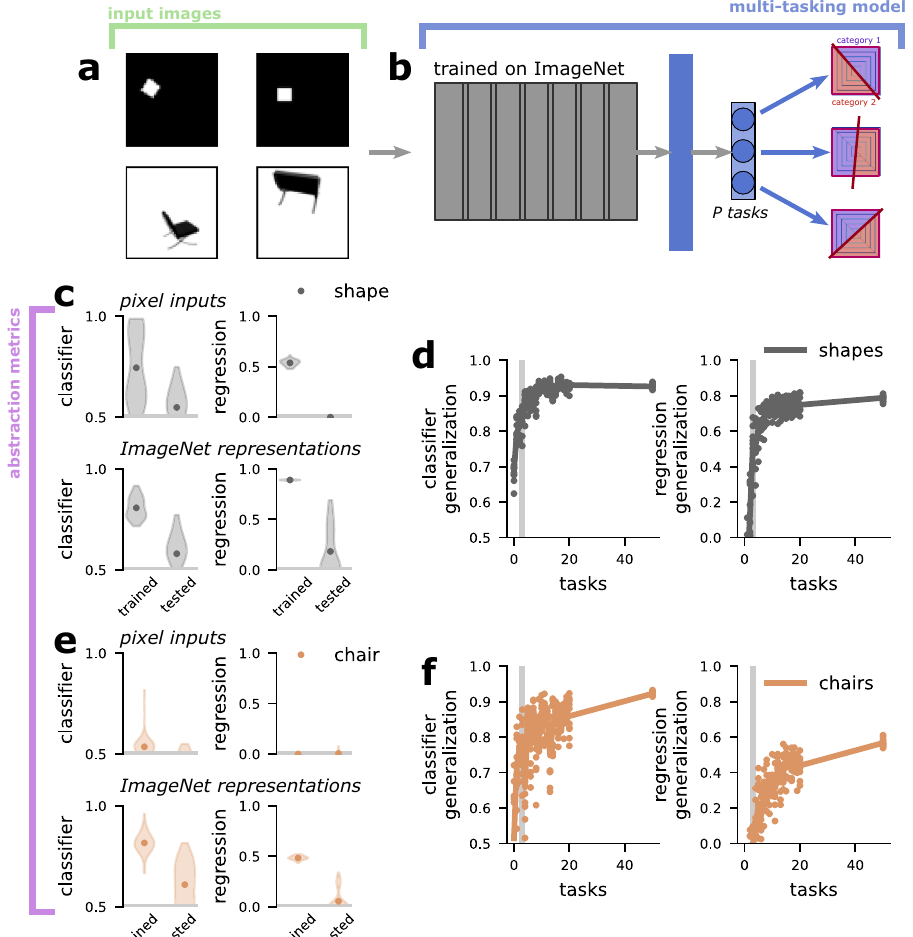
Fig.6|Themulti-taskingmodelproducesabstractrepresentationsfromimage inputs. a Examples from the 2D shape dataset 43 (top) and chair image dataset 42 (bottom). The 2D shapes dataset is from: Matthey, L., Higgins, I., Hassabis, D. & Lerchner, A.dsprites: Disentanglement testing sprites dataset. https://github.com/ deepmind/dsprites-dataset/(2017). b Schematic of modi fi ed model. The multi- taskingmodelnowbeginswithanetworkedpre-trainedontheImageNetchallenge, followed by a few additional layers of processing before learning binary tasks as